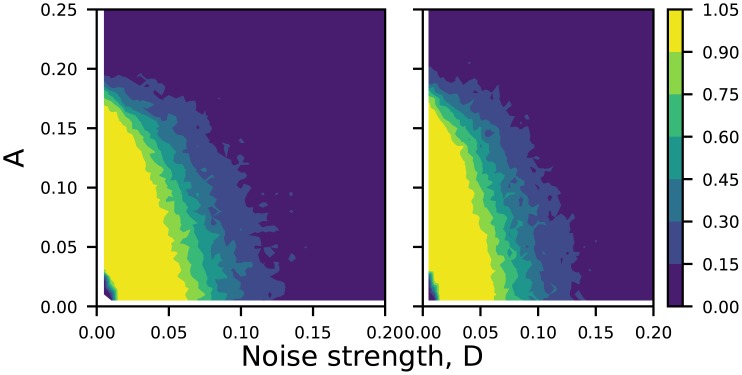
Probability of obtaining NOR logic, obtained from numerical simulations (with b = 0.025, on the left) and NAND logic (with b = −0.025, on the right) in the parameter space of forcing amplitude A (y-axis) and noise strength (x-axis) in Eq 3, with ω = 0.75 and inputs I1/I2 take value −0.025 when logic input is 0 and value 0.025 when logic input is 1.